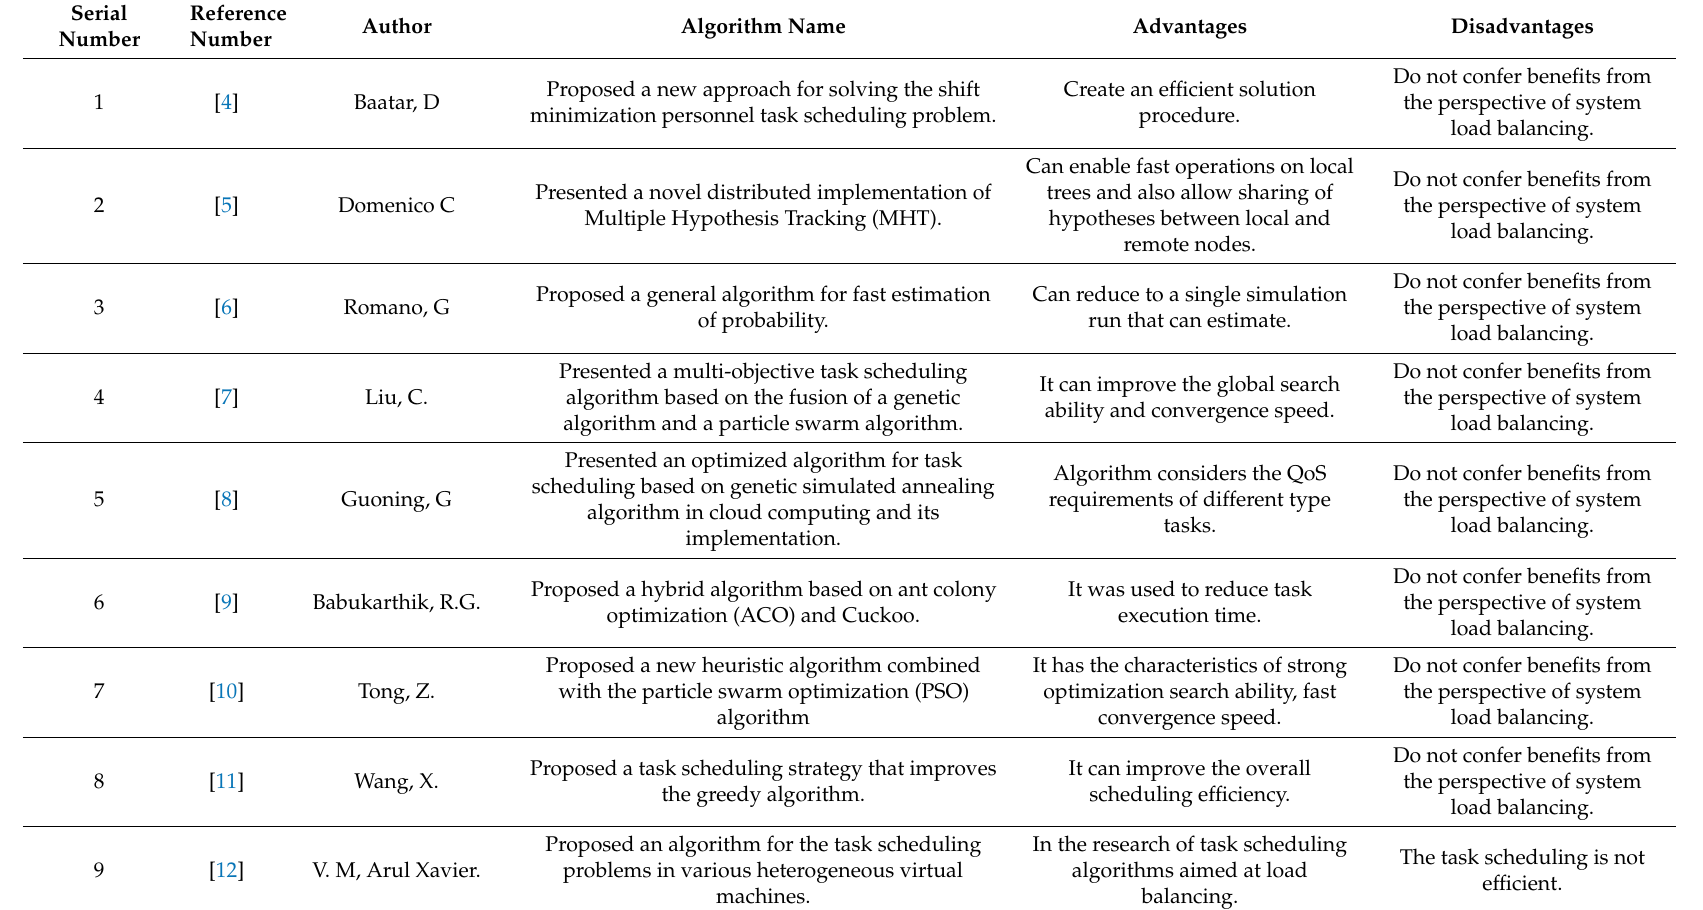
Table 1. The comparison of the relevant work